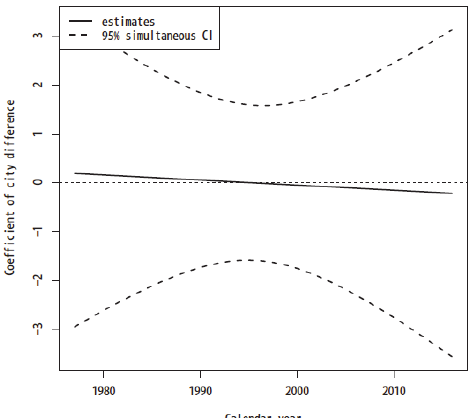
Fig. 20. Scatter plot of keyword's appearance by cluster in